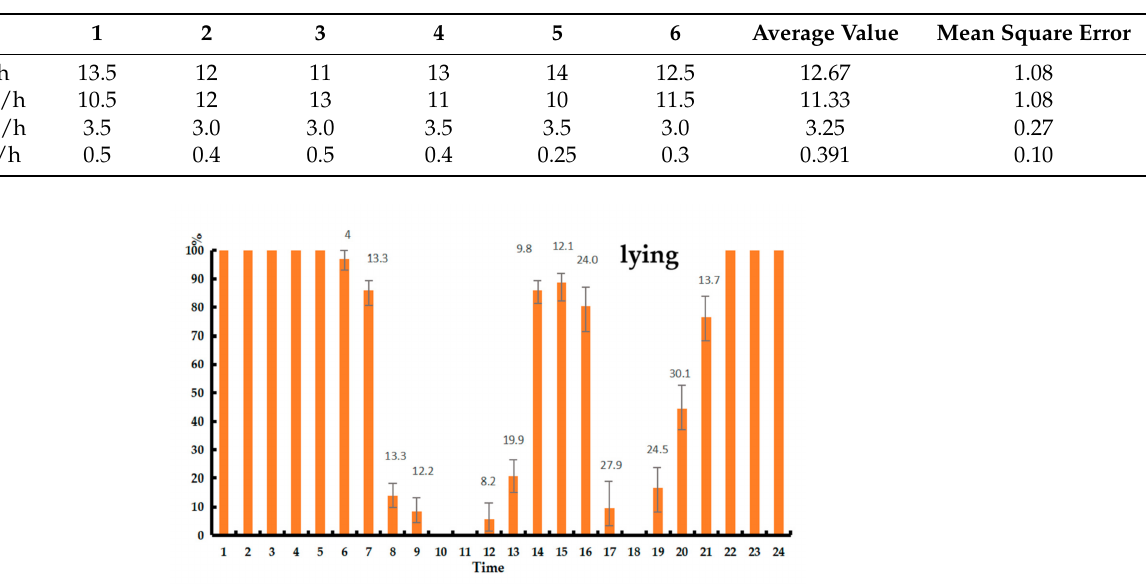
Table 4. Timetable for sows in standing, lying, feeding and drinking within 24 h.